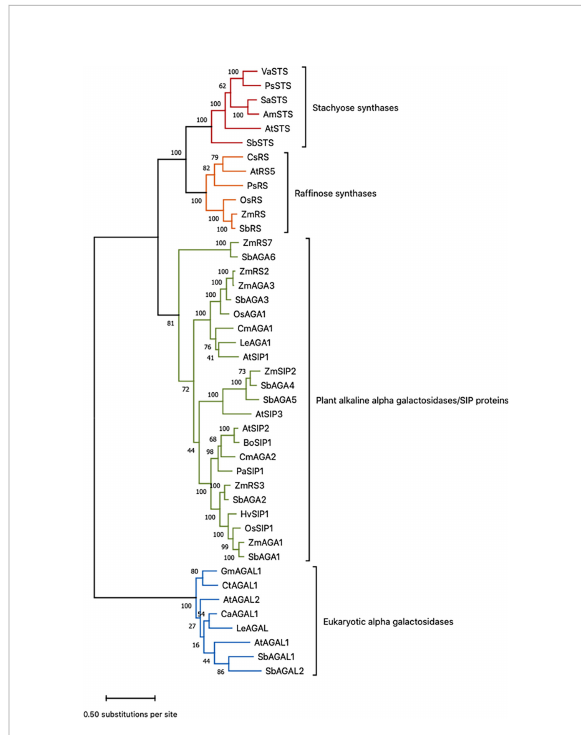
FIGURE 1 Phylogenetic tree of sorghum proteins and functionally validated RS, STS, and AGA proteins from other species. Refer to Table S1 for gene name to gene ID conversions. Scale bar shows the number of amino acid substitutions per site. This is the tree with the highest log likelihood out of 100 trees. The number of trees in which the associated protein sequences clustered together is shown as a number next to the branches of those sequences.